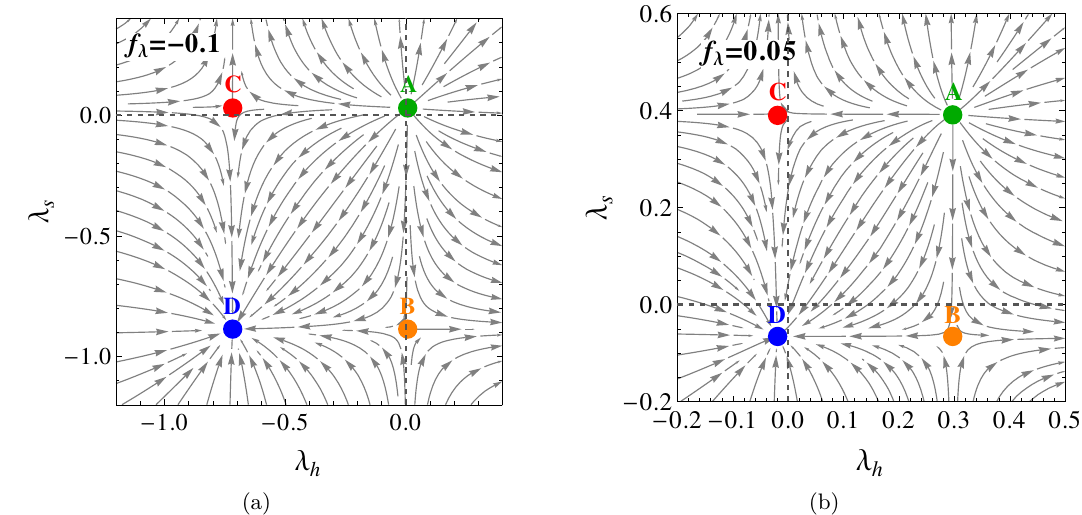
Figure 2 . (a) Phase space diagram in the ( λ h , λ S ) plane for f λ = − 0 . 1 and the couplings set at FP in table 2. (b) Phase space diagram for f 1A ,a the UV. Color dots correspond to the fixed points listed in table